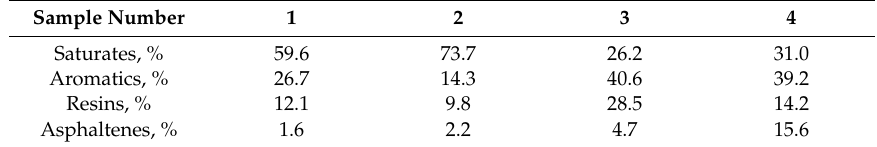
Table 2. SARA analysis (%) of studied oil samples.